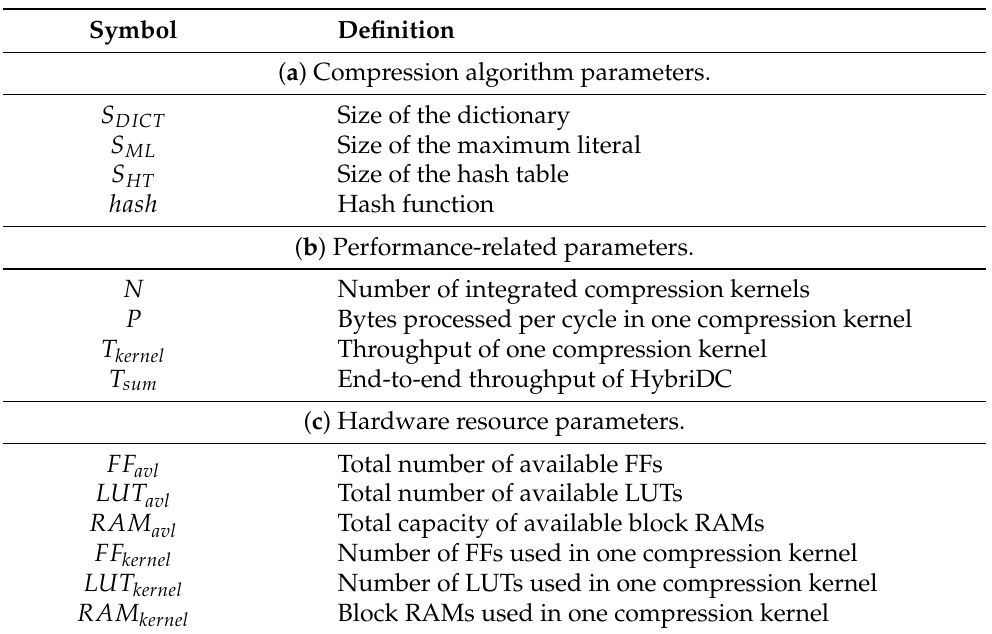
Table 2. Parameters related to the compression kernel